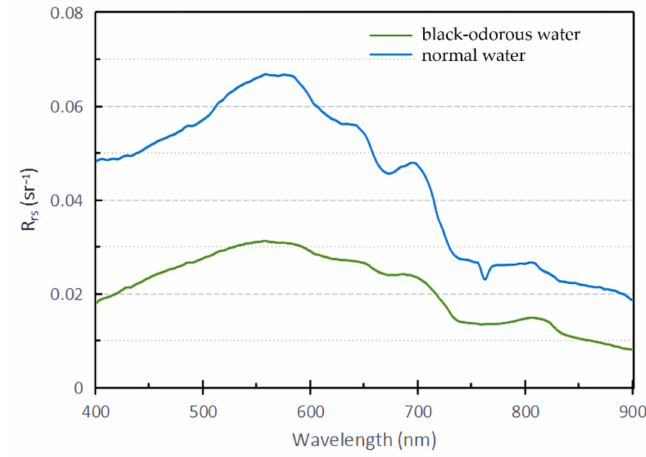
Figure 3. Comparison of black-odorous water with normal water.